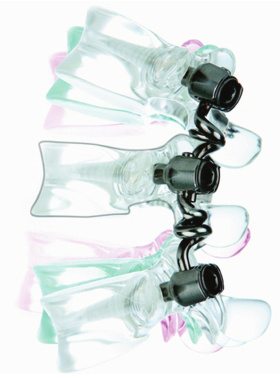
Figure 8: The Bioflex dynamic stabilization system.